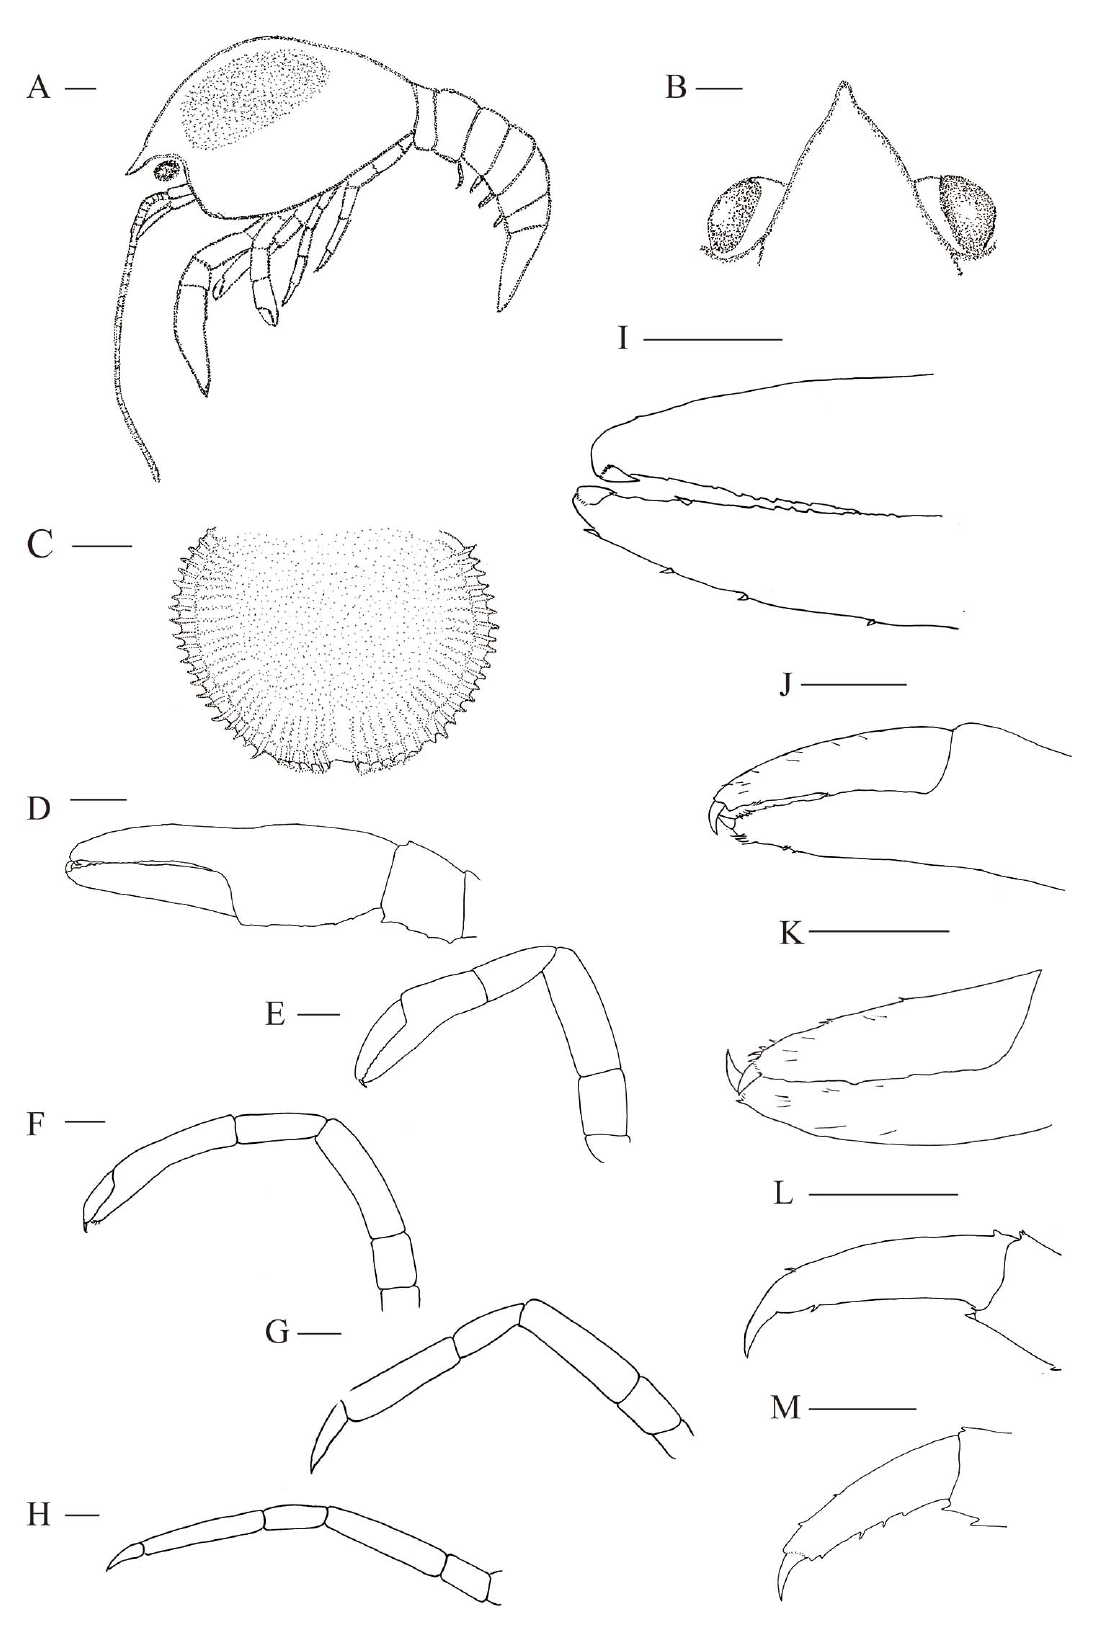
Figure 1. Juvenile Stage I of Austropotamobius torrentium . ( A ) Habitus, lateral view; ( B ) eyes and rostrum, dorsal view; ( C ) tail fan, dorsal view; ( D–H ) pereiopods 1–5, dorsal view or lateral view; ( I–M ) distal segments of pereiopods 1–5, dorsal view or lateral view. Scale bars: 0.25